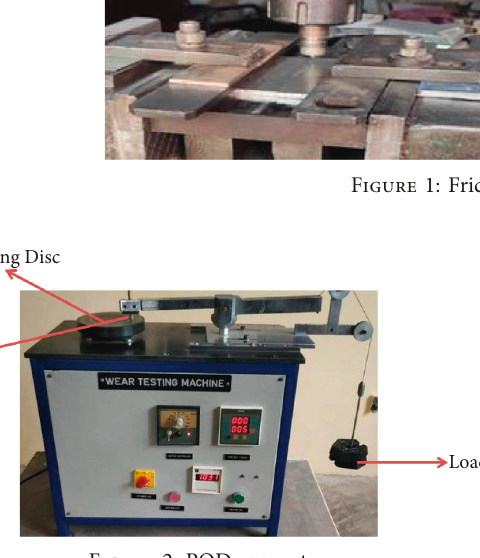
Figure 2: POD apparatus. Table 2: Wear test parameter